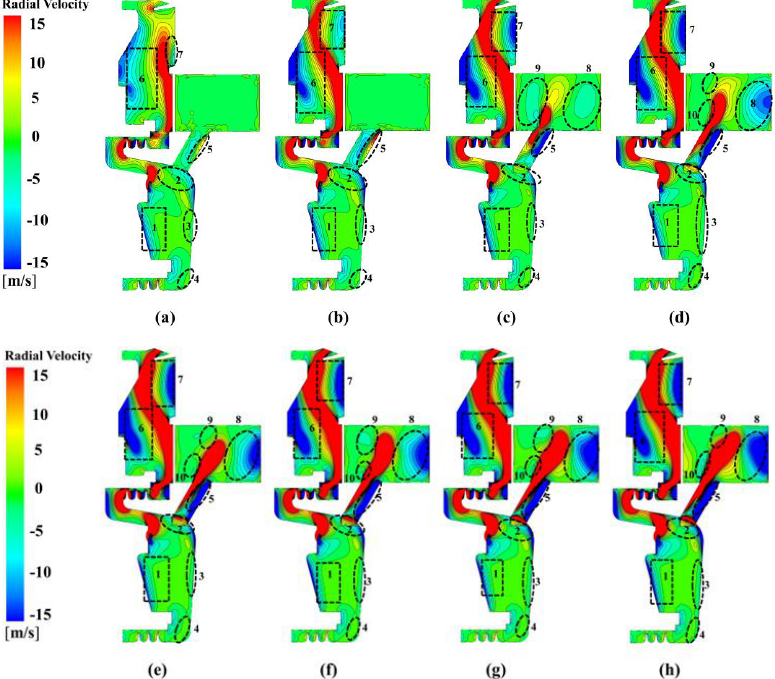
Figure 3. Distribution of radial velocity at Re = 9.5172 × 10 5 at different nozzle pressure: ( a ) − 30% design pressure, ( b ) − 20% design pressure, ( c ) − 10% design pressure, ( d ) design pressure, ( e ) +10% design pressure, ( f ) +20% design pressure, ( g ) +30% design pressure, and ( h ) +40% design press − ure.